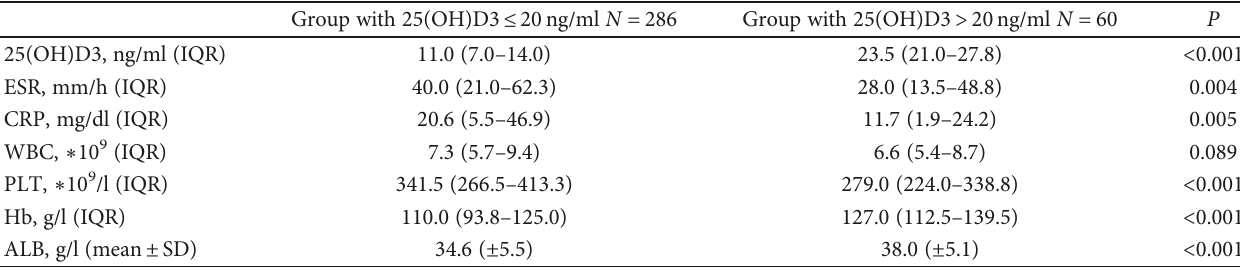
Table 2: Characteristics of laboratory parameters.